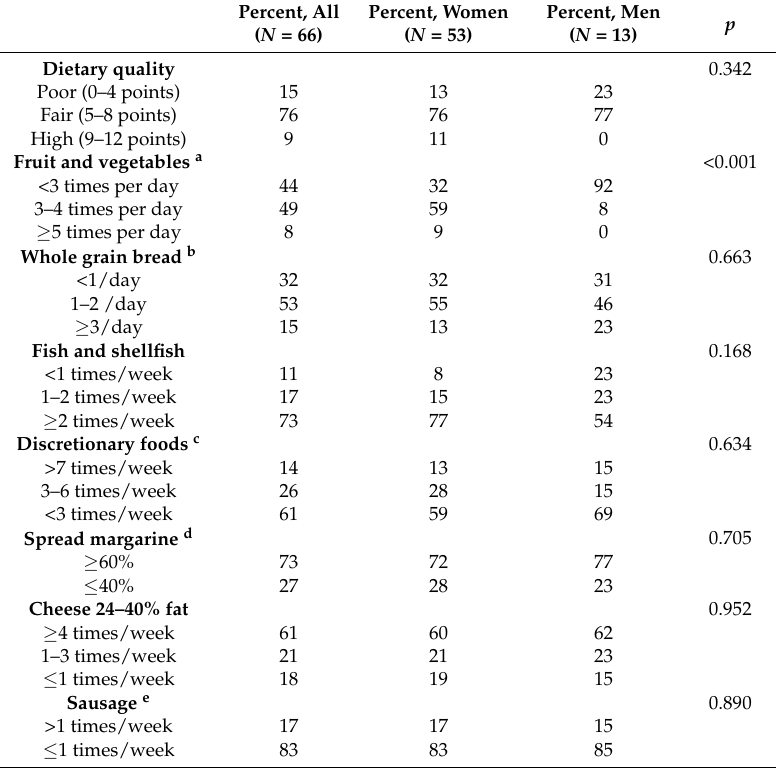
Table 2. Dietary intake of the 66 Swedish patients with rheumatoid